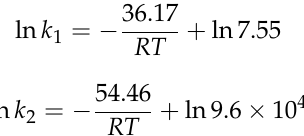
Figure 6. The kinetic parameters at different temperatures, ( a – c ) the fitting curve of the extraction and hydrolytic rate constant at 140 °C, 160 °C, and 180 °C, respectively; ( d ) the Arrhenius